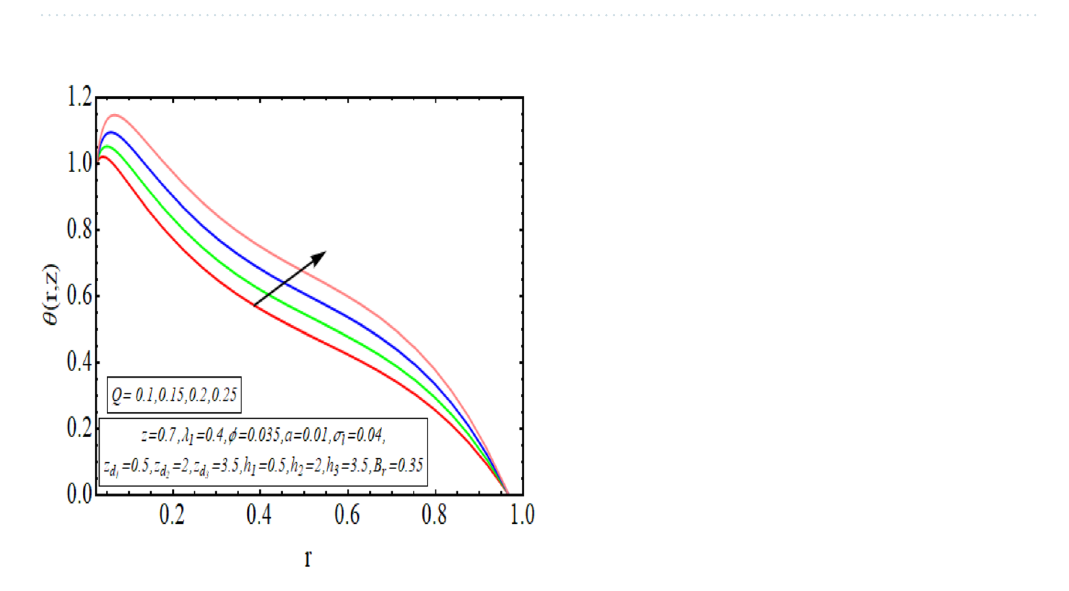
Figure 10. Temperature profile for Q